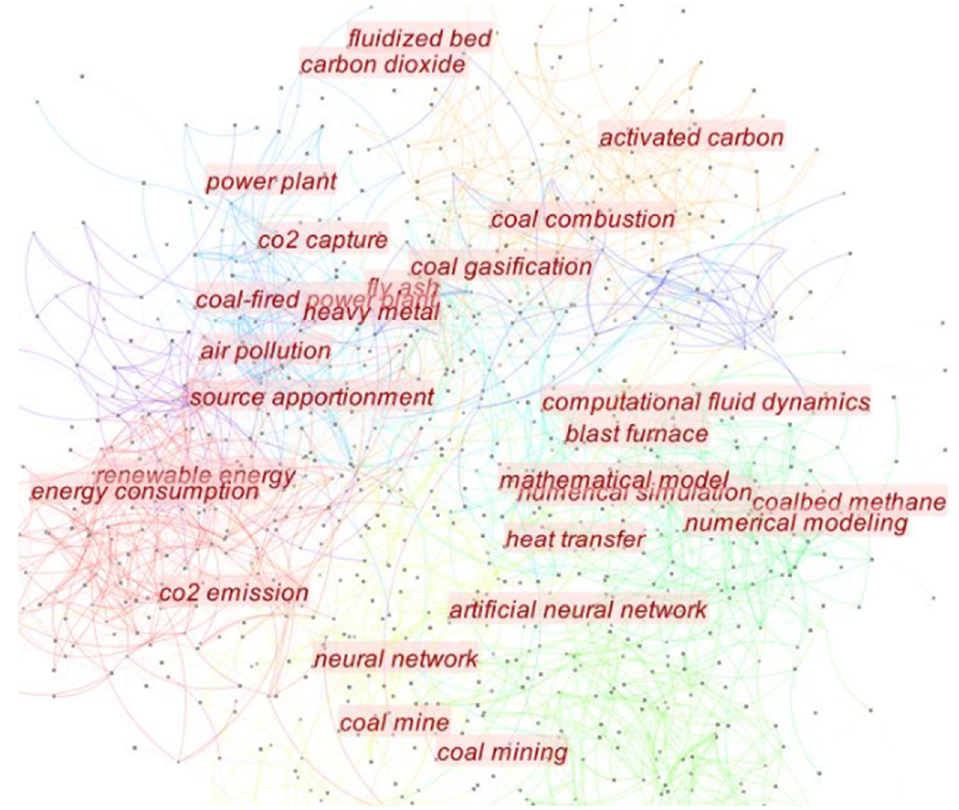
Figure 9. Visualization of authors’ key words.